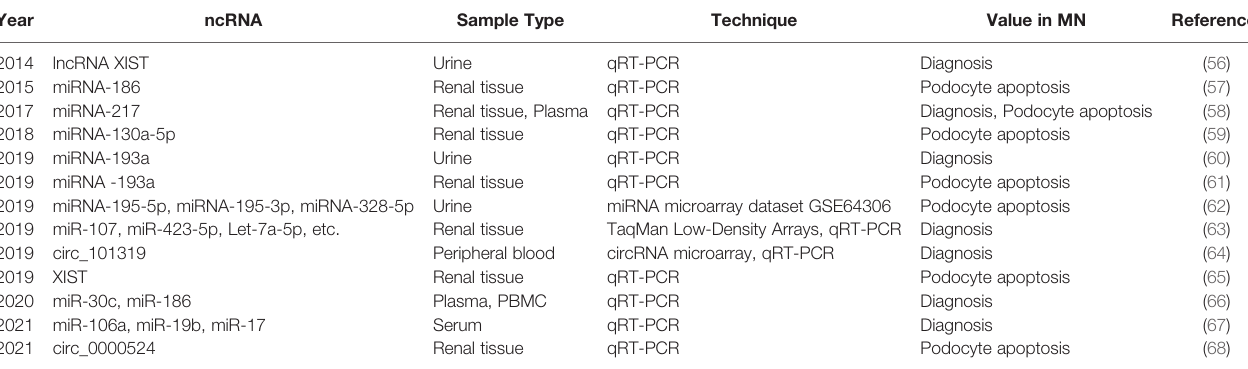
TABLE 3 | Summary of research progress on MN-related ncRNA biomarkers.